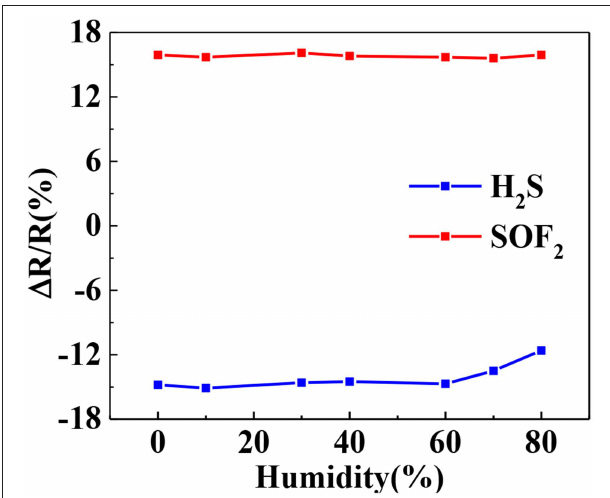
FIGURE 12 | Proposed mechanism for the adsorption behavior of H 2 S and SOF 2 molecules on Au-SnO 2